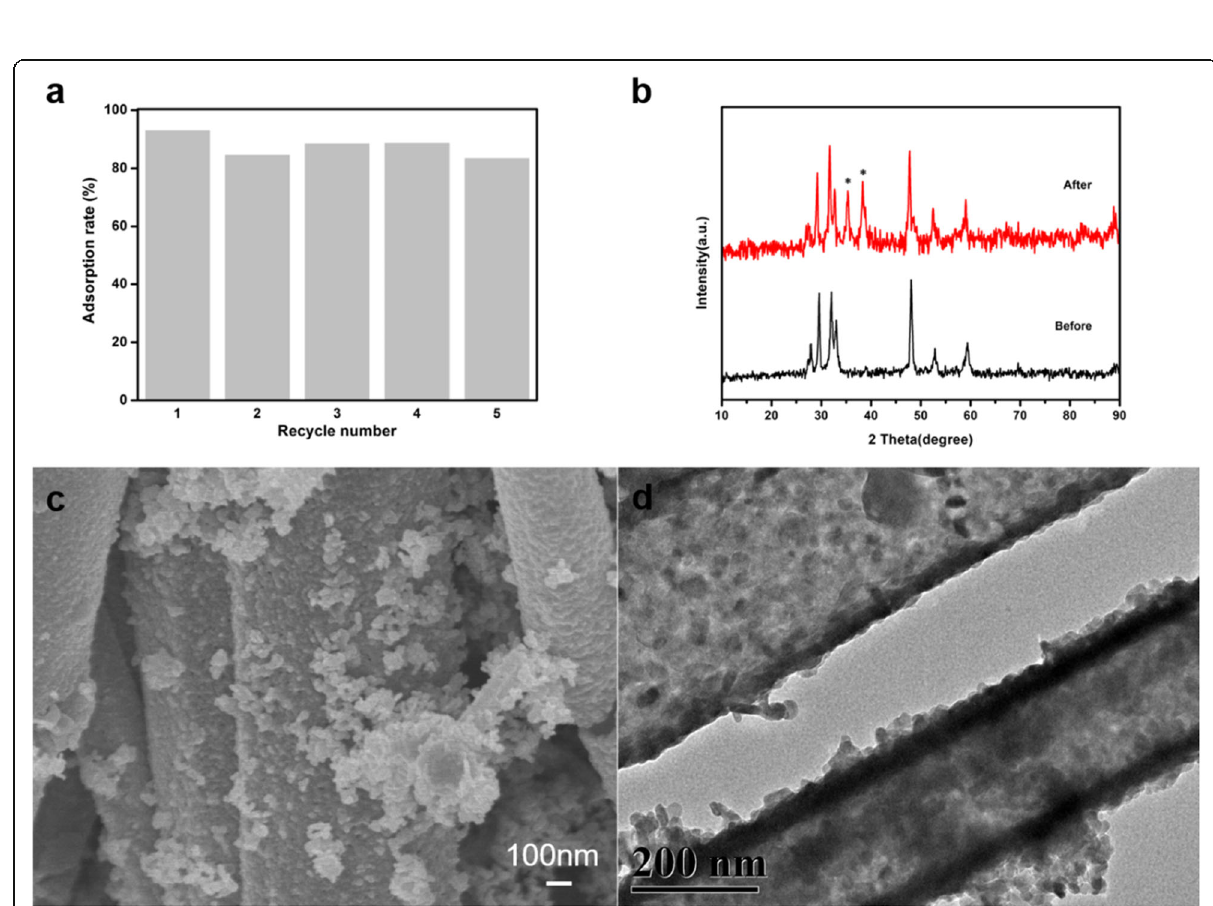
Fig. 11 Repeatability experiments of copper sulfide adsorption EE2 ( a ); XRD patterns of CuS, used CuS ( b ); SEM image of used CuS ( c ); and TEM image of used CuS ( d